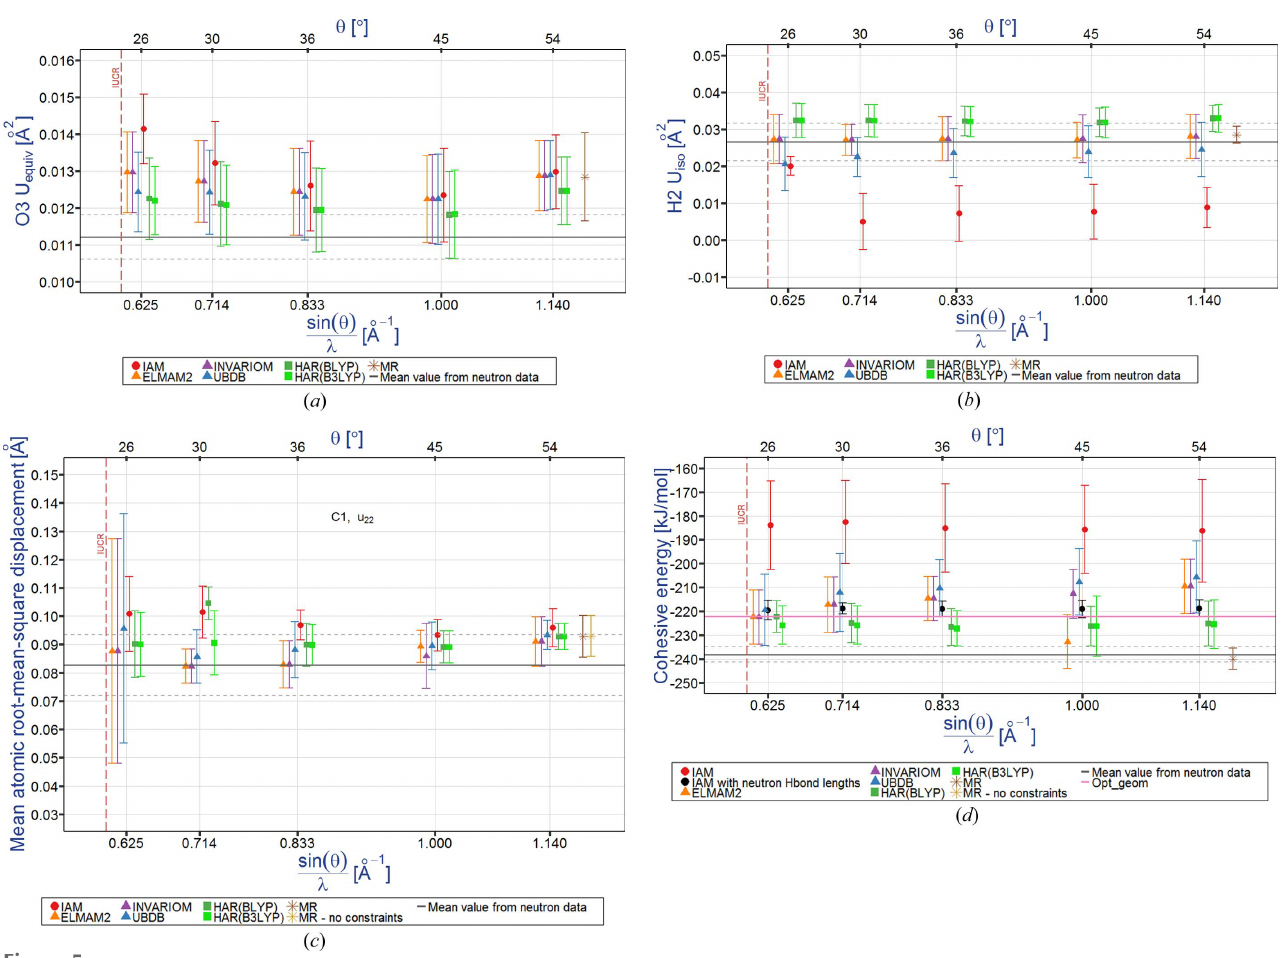
Figure 5 Typical dependencies of the thermal parameters and cohesive energy on the data resolution and the electron density model refined against X-ray and neutron data for: ( a ) U eq for the O3 atom, ( b ) U iso / U eq for the H2 atom and ( c ) U 22 for the C1 atom and ( d ) cohesive energies of crystals. In the case of hydrogen atoms, the plot contains U iso values for IAM and UBDB, ELMAM2 and INVARIOM refinements and U eq for the other methods. Opt_geom refers to the cohesive energy calculated for the optimized